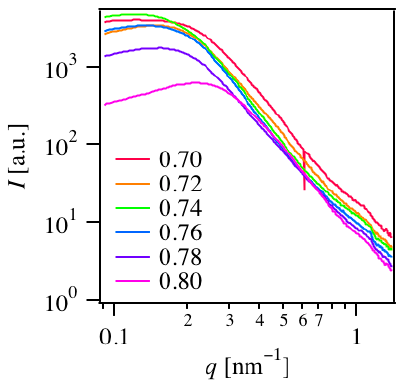
Figure 10. Circularly-averaged SAXS intensity profiles of the carboxylated SR gels at φ a = 0.70–0.80.